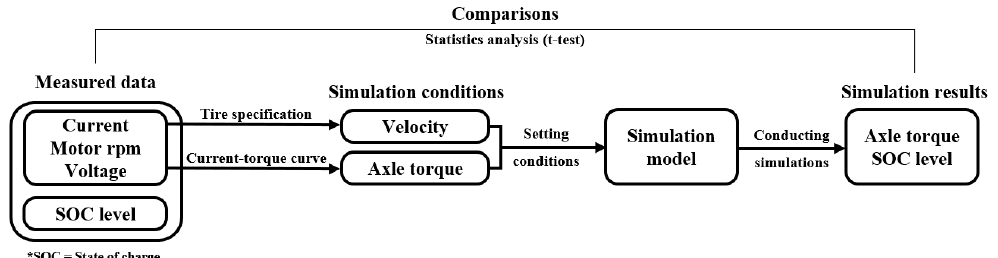
Figure 6. Flow chart of the test procedure for development and verification of electric AWD tractor .